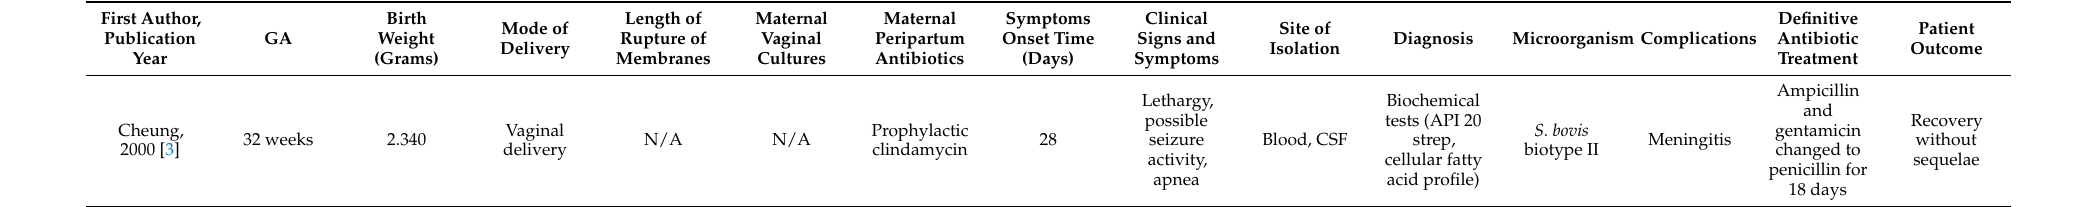
Table 2. Characteristics of cases of late-onset sepsis caused by S. gallolyticus or S. bovis biotype